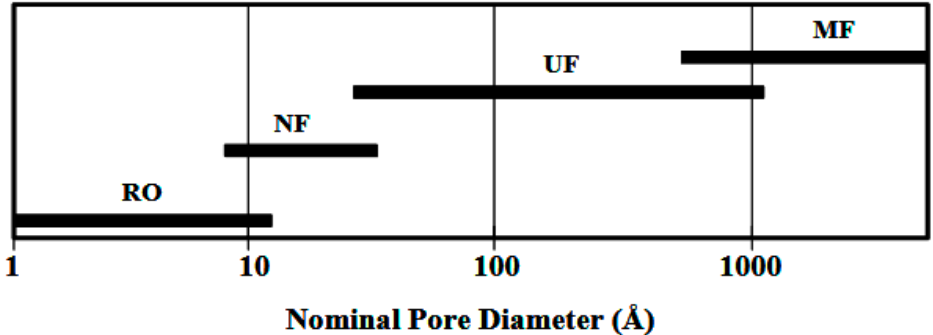
Figure 4. Range of nominal membrane pore sizes.